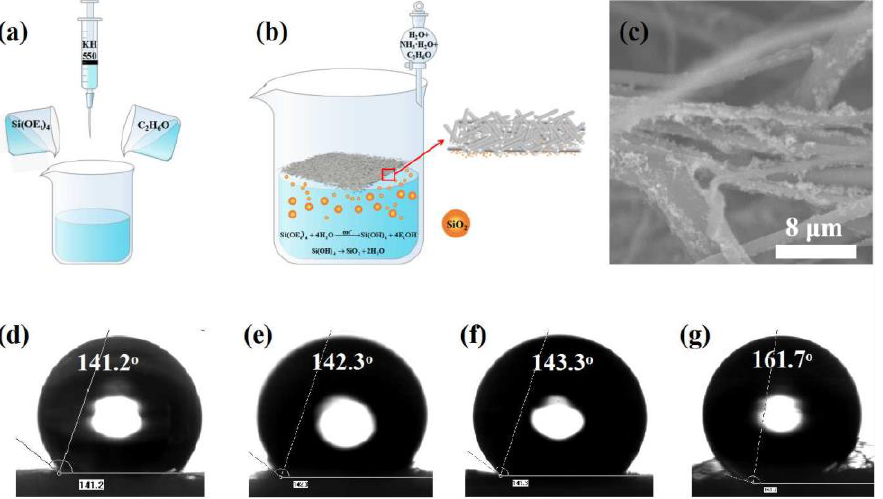
Figure 4. ( a ) Preparation of finishing solution, ( b ) hydrophobic finishing of SiO 2 precipitation on lower side of nonwovens, ( c ) after the finishing, SEM photograph of lower side of nonwovens. The CAs of as-prepared MB nonwovens: ( d ) the upper side and ( e ) the lower side prior to finishing; correspondingly, ( f ) the upper side and ( g ) the lower side after the finishing.